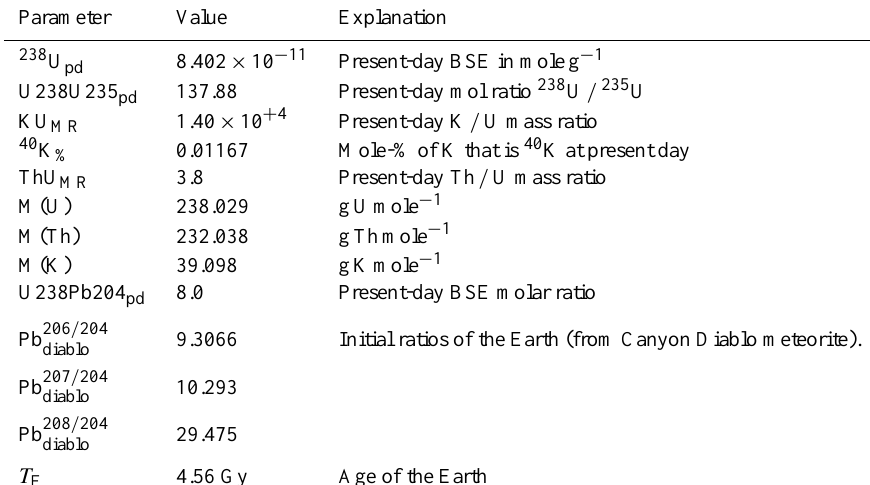
Table 2. Parameters and values used for initialisation of trace elements.